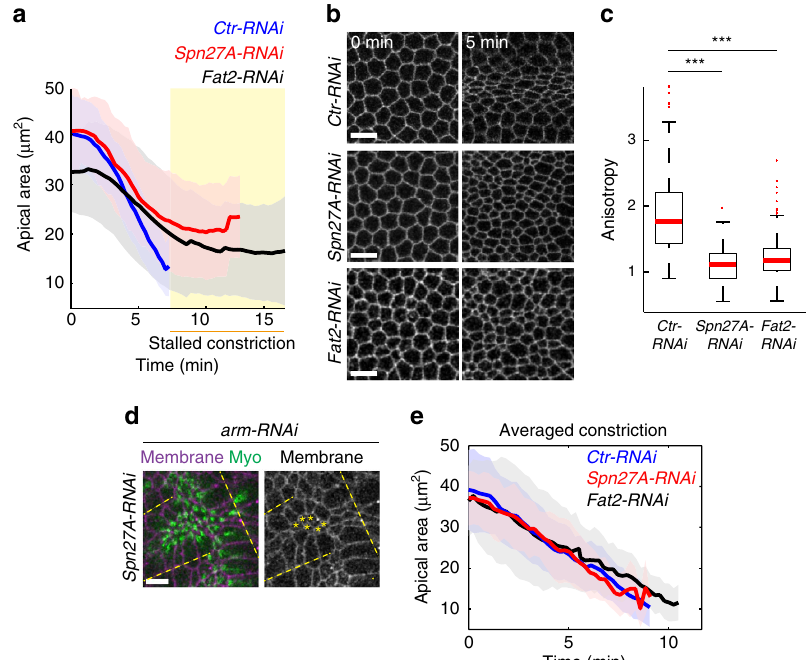
Figure 2 | Tissue shape is critical for proper cell shape changes. ( a ) Mean apical cell area over time calculated for Ctr-RNAi ( n ¼ 119 cells, 2 embryos), Spn27A-RNAi ( n ¼ 134 cells, 2 embryos) and Fat2-RNAi ( n ¼ 418 cells, 3 embryos) embryos during VF formation. Shaded area indicates s.d. ( b ) Images of VF cell outlines in live embryos depleted for the indicated gene before and 5min after the onset of cell constrictions. ( c ) Box-and-whisker plots of cell anisotropy 7min after the onset of cell constriction for the embryos analysed in a . Cell anisotropy is the length of the cell along the horizontal axis divided by the vertical length, such that cells elongated along the a-p axis exhibit anisotropy 4 1. Isotropic is anisotropy ¼ 1. ( d ) Injection of arm-RNAi locally induced tissue tears (dotted lines) that disrupted tissue integrity. Cell constriction was followed for cells between tears (asterisks). ( e ) Mean apical area over time for 16 Ctr-RNAi , 18 Spn27A-RNAi and 15 Fat2-RNAi constricting cells between tears after arm-RNAi injection. Shaded area indicates s.d. Scale bars, 10 m m. *** P o 0.001, t-